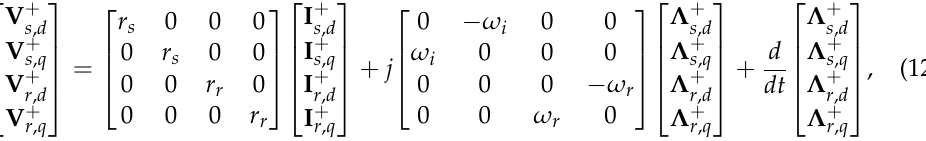
Figure 2. Equivalent circuit of EFR in dq + synchronous reference frame: ( a ) d + and ( b ) q + .